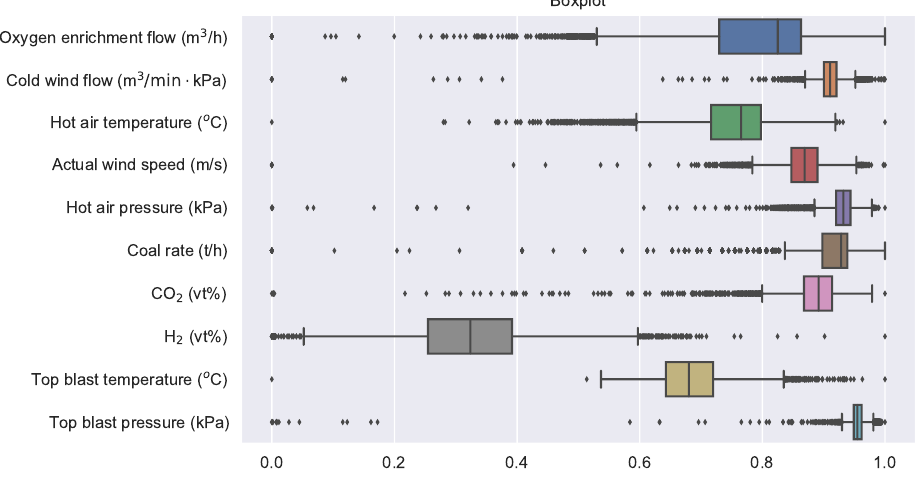
Figure 10. Box-plot for related variables (extreme